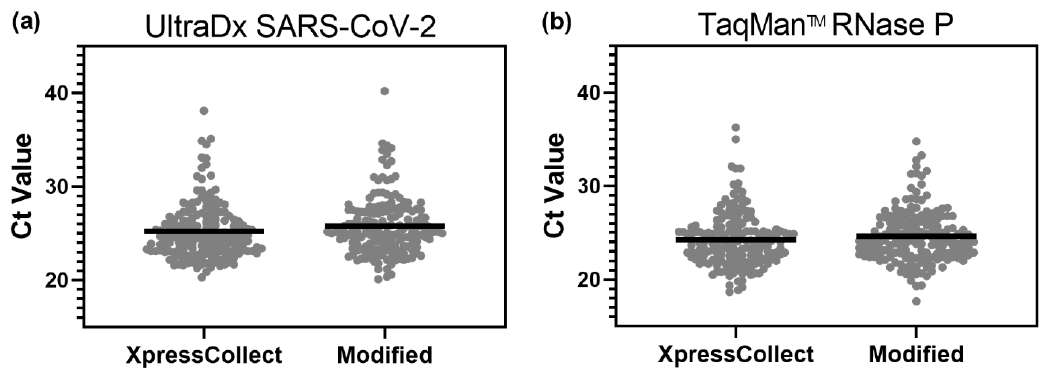
Figure 6. RNase P Ct values for 176 self-collected samples using the XpressCollect compared to the modified swab concept B, as detected by either the ( a ) UltraDx SARS-CoV-2 or ( b ) TaqMan TM RNase P assay. The mean Ct value for each condition is marked by a horizontal line.